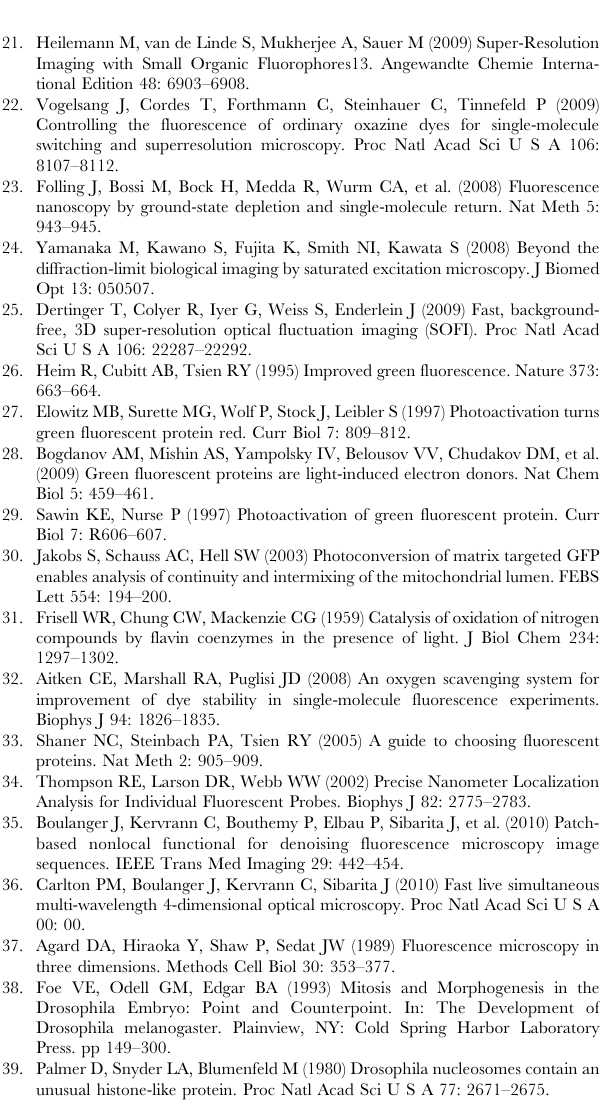
Figure S6 Selection of right Gaussian width removed noise and improve PALM resolution. (A) A histogram of Gaussian width in X and Y directions measured during PALM reconstruction of denoised and deconvolved simulation image with SNR 12.43 (Figure 2). Note that width dis-tribution is very wide with a significant peak around 1.2 pixel. This suggests that peaks smaller than , 1.0 pixel or larger than , 1.6 pixel are false positives due to noise. (B) Distribution of Gaussian width in areas of interest (green) and background (red). Inset shows the corresponding green and red-boxed regions of final PALM reconstruction image. This shows that only major peaks are the right PSF sizes and smaller or larger PSFs are actually false positives. The green shade region on the histogram shows the peak width automatically selected by reconstruction program and the rest is thrown away. This approach easily identifies the right PSF shape in any data set, and effectively throw away false positives mostly due to noise. (C) One-dimensional localization precision (red) in the simulated PALM reconstruction of denoised and deconvolved series. Dotted line is before width selection and filled line is after selection. The blue lines show fraction of peaks which constitute the helix among the total number of peaks. Due to false posi-tives and structures